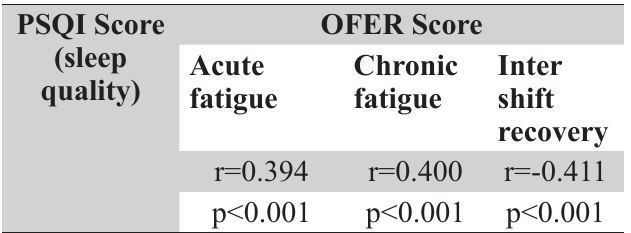
Table 4: Correlation between PSQI (sleep quality) and OFER (fatigue) scores of the participants